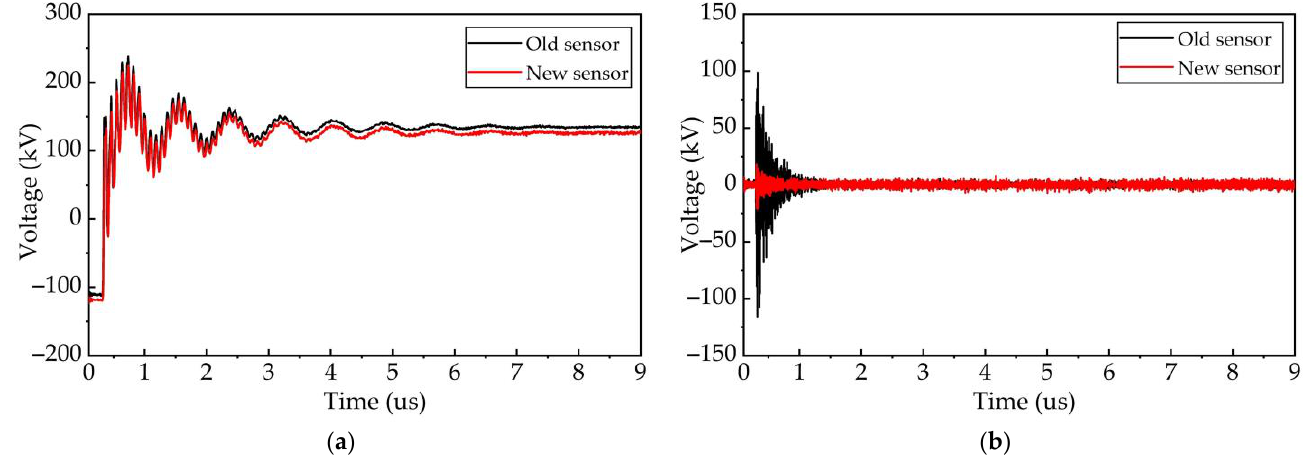
Figure 19. Time domain waveform of VFTO. ( a ) VFTO time domain waveform with frequency lower than 70 MHz; ( b ) VFTO time domain waveform with frequency higher than 70 MHz.